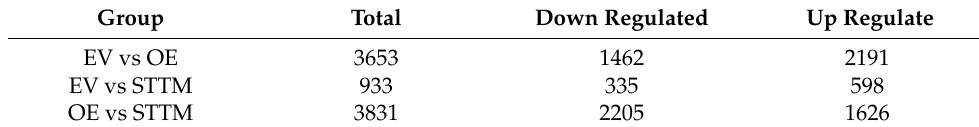
Table 4. The number of differentially expressed genes in each comparison group.